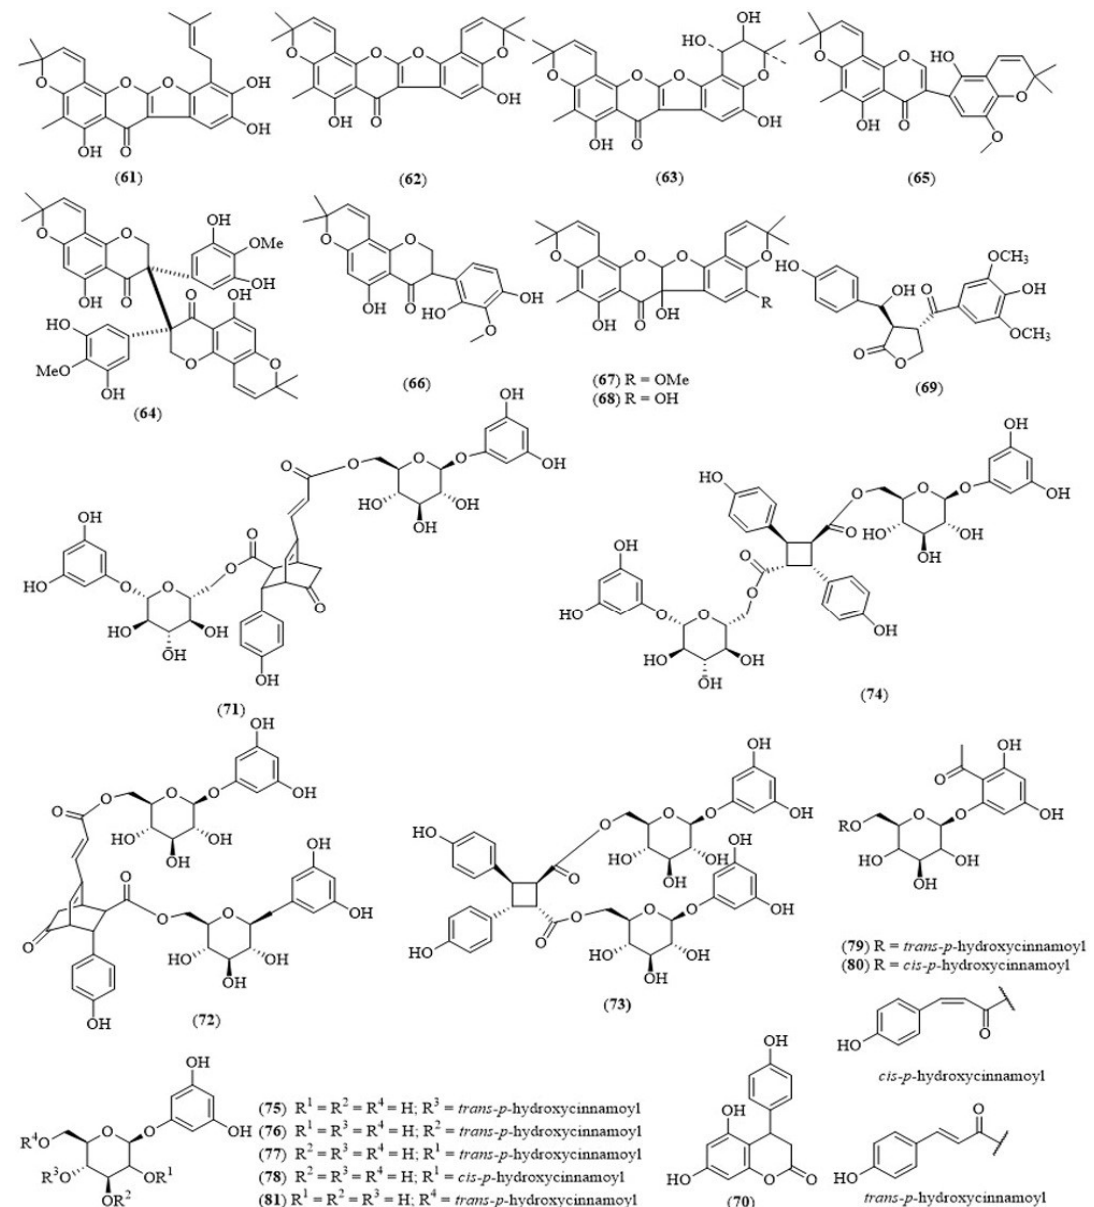
Figure 7. Structures of selected compounds isolated from Tadehagi triquetrum.